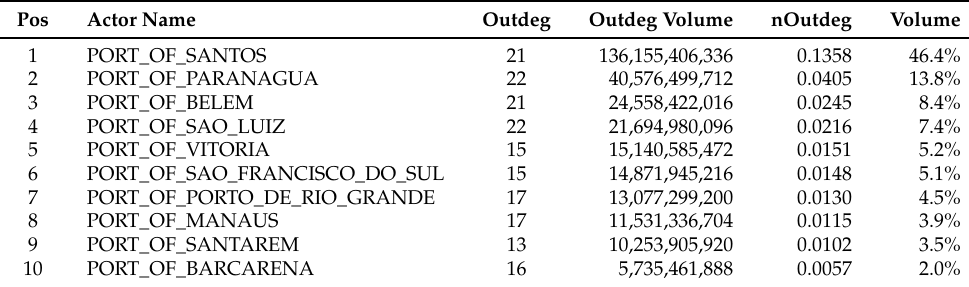
Figure 7. Tie strength countries (red nodes) and ports (blue nodes). Table 2. Ports